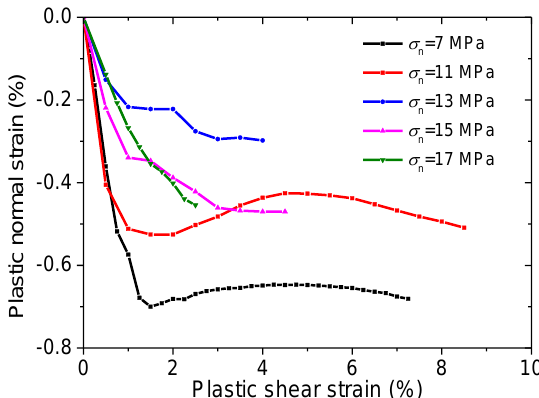
Figure 8. Plastic shear and plastic normal strain relations of the granite samples under different normal stresses.